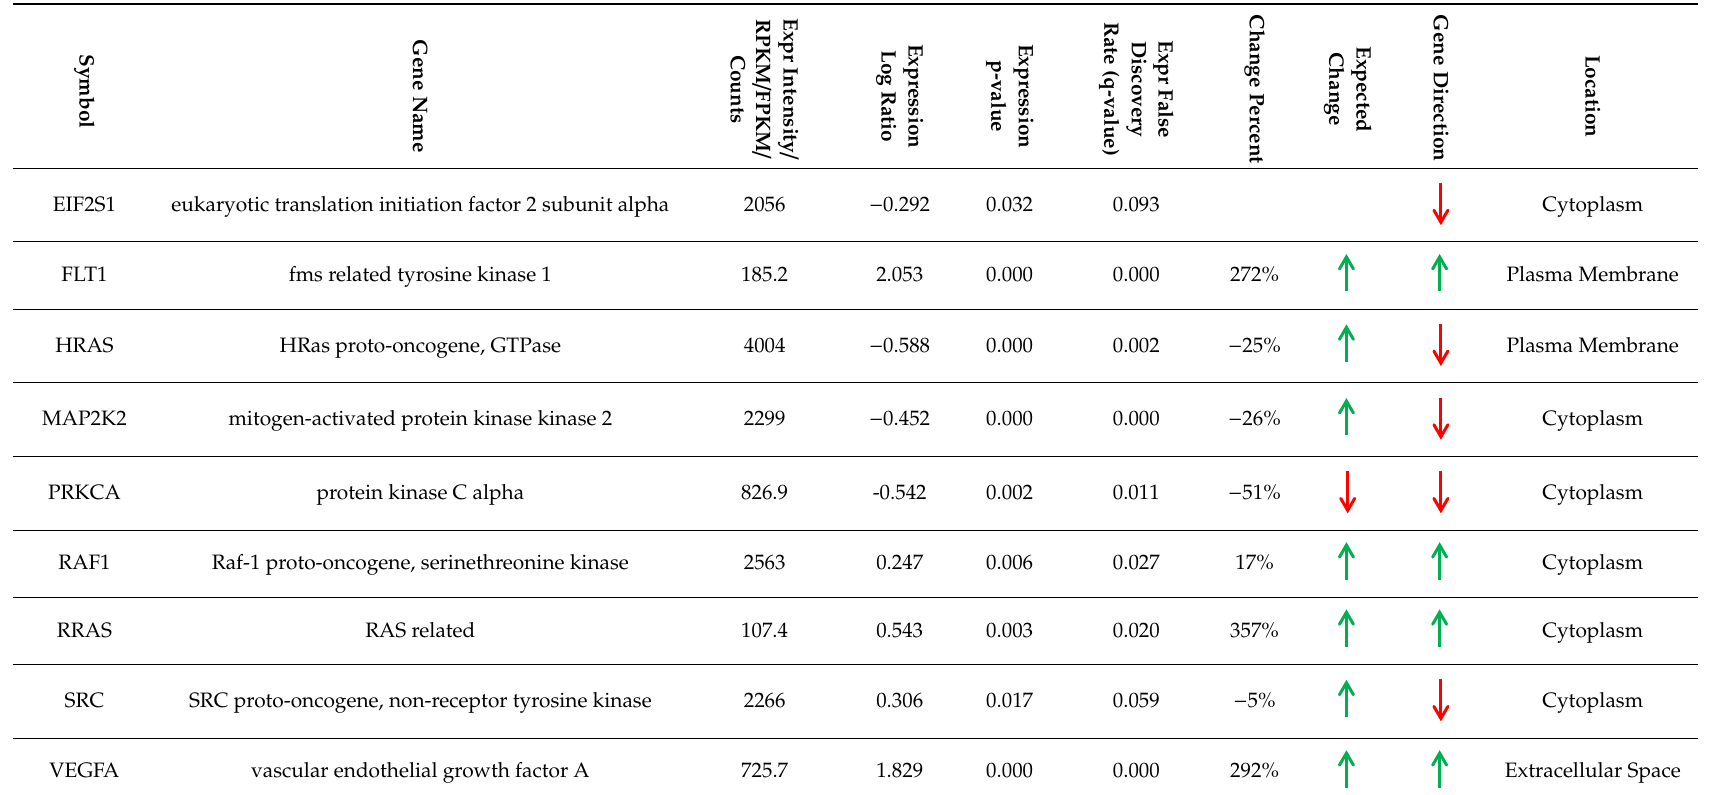
Green arrows- upregulation of the gene. Red arrows-downregulation of the